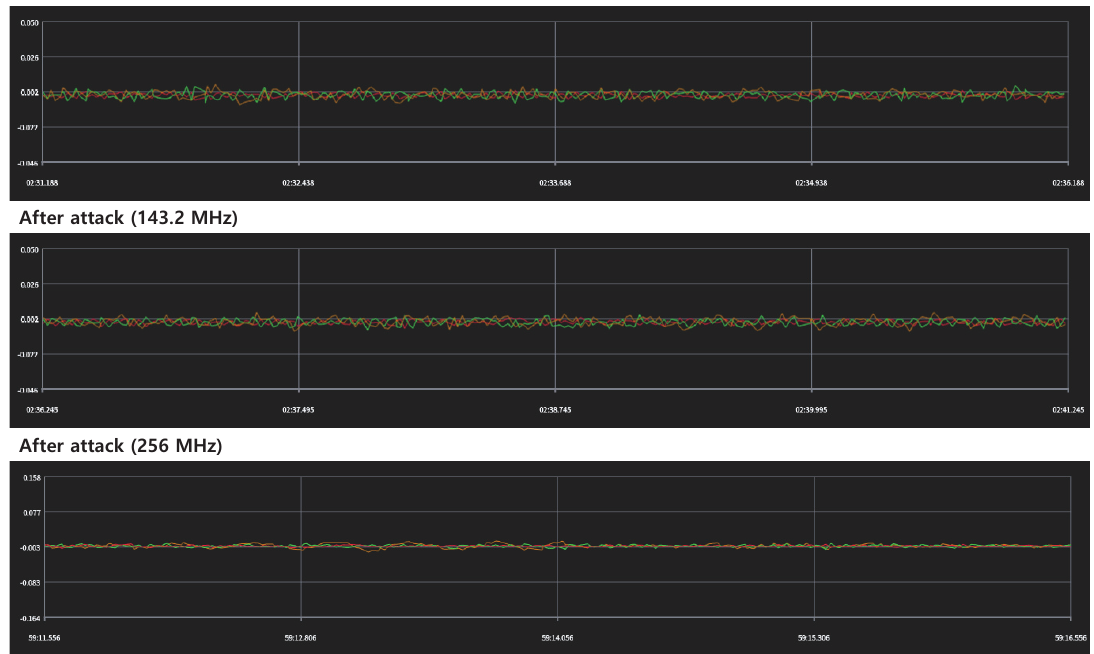
Figure 7. Monitored gyroscope data with high power IEMI